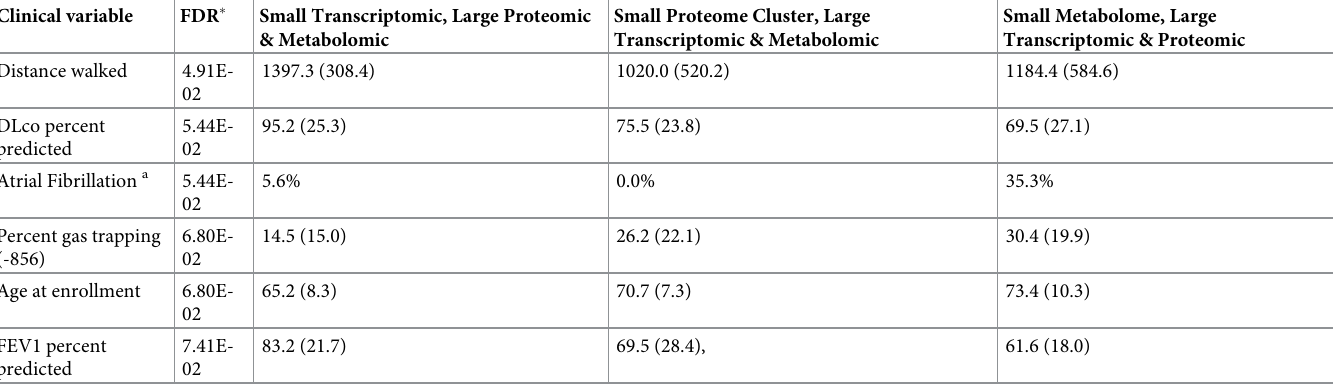
Table 6. Post-clustering clinical associations of subjects that are in the small subtype for one of the -omics data sets, but not the